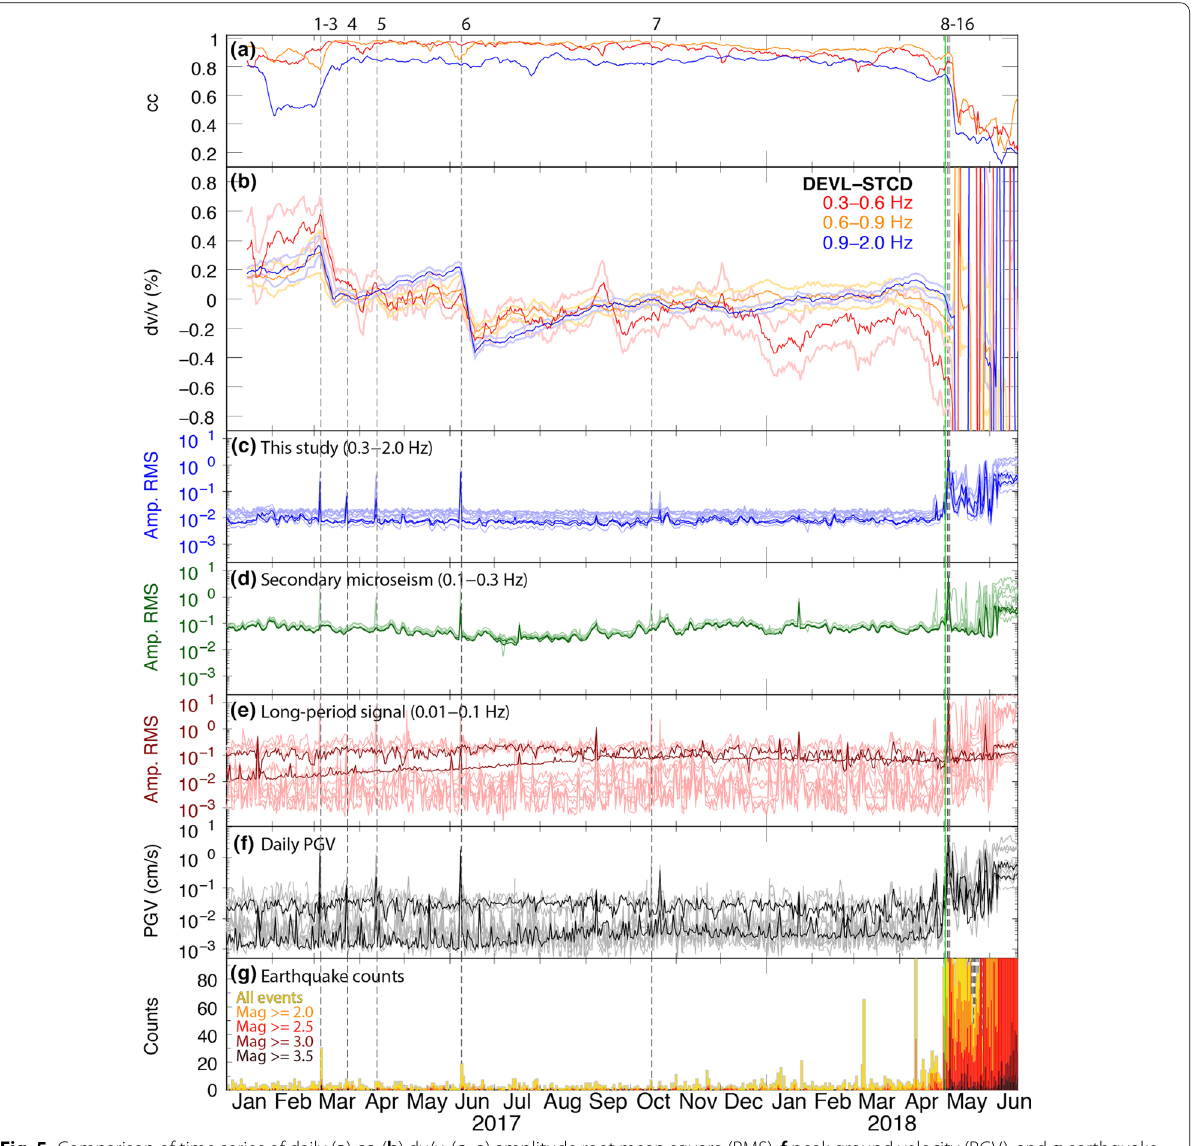
Fig. 5 Comparison of time series of daily ( a ) cc, ( b ) d v / v , ( c – e ) amplitude root mean square (RMS), f peak ground velocity (PGV), and g earthquake numbers in the Kilauea area. The dark and light colors in a and b represent the estimated d v / v and the corresponding errors in different frequency bands (red: 0.3–0.6 Hz, orange: 0.6–0.9 Hz, and blue: 0.9–2.0 Hz). The amplitude RMS of daily seismic records is calculated in c 0.3–2.0 Hz, d 0.1–0.3 Hz and e 0.01–0.1 Hz, respectively. The dark and light color curves in c – g indicate the results for the Station DEVL and Station STCD and the other stations. Vertical dashed lines mark the occurrence time of the earthquakes with M ≥ 3.5 (Fig. 1 and Additional file 1: Table S1). Green line marks the beginning time of the